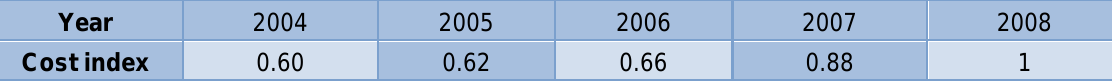
Table 1 Construction cost index value in the West Bank (PECDAR, 2009) To deflate the cost of a project in a certain year to cost in year 2008, its cost is divided on the cost index value of that year.